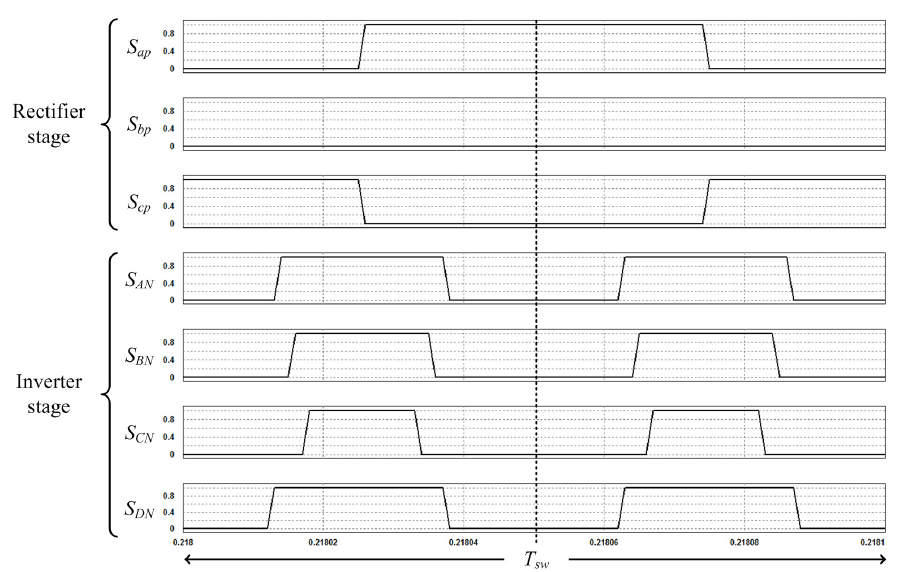
Figure 7. Combination of the switching pattern for the dual outputs in the proposed